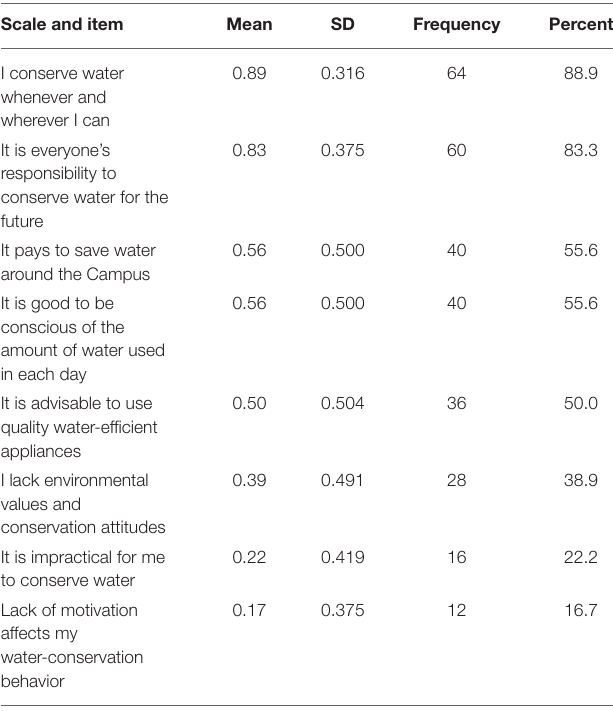
TABLE 1 | Motivation inclinations of managers toward water conservation in the workplace ( N =